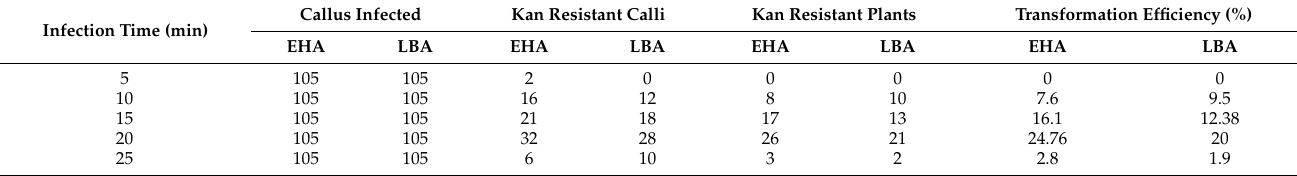
Table A3. Effect of infection time (mins) on transformation efficiency of callus derived from seeds of P. scrobiculatum L. Infection Time (min)